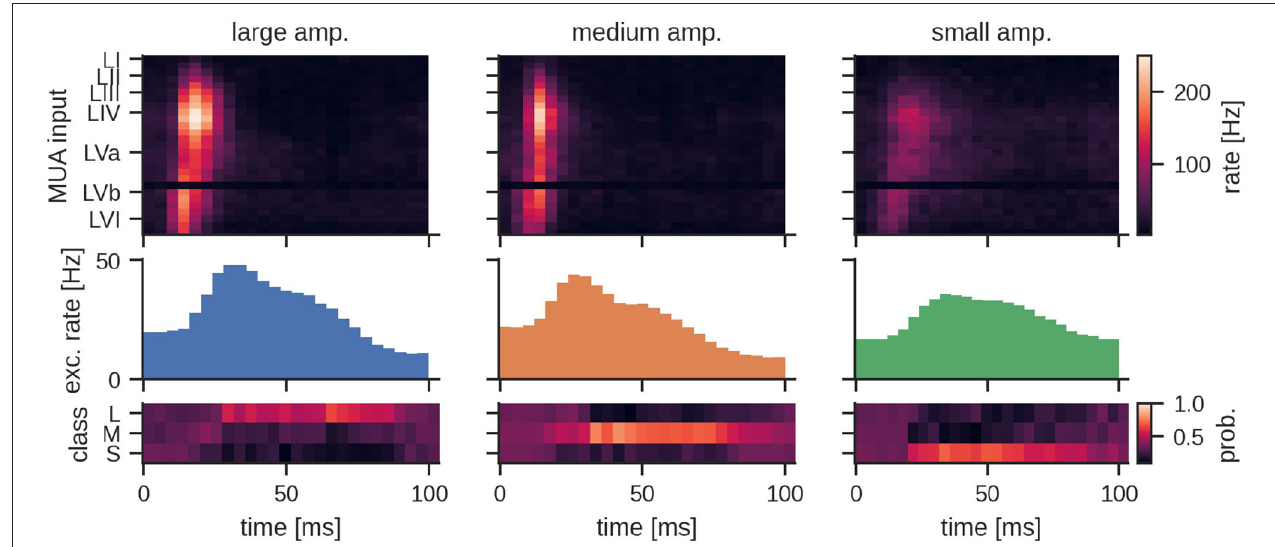
FIGURE 5 | Peristimulus time histogram (PSTH) for MUA inputs and the excitatory population activity of the LSM for the three different stimulation amplitudes. Layers III, IV, and Va exhibit a particularly high firing rate depending on the amplitude of the stimulation. The bottom row shows the mean predicted class probability (Large, Medium, and Small stimulation amplitude) for the corresponding examples in the test set. See Section 4 for